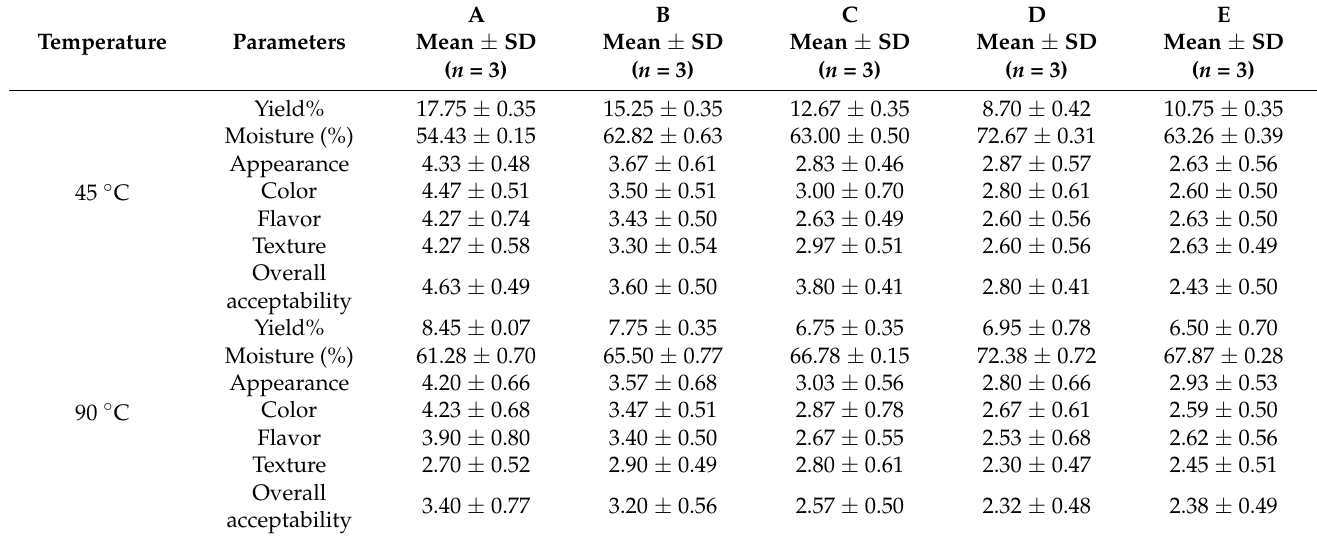
Table 4. The effect of water temperature during lupin milk production and coagulation methods on the yield and sensory analyses of cheeses produced from lupin milk of the PBA Jurien cultivar after storage of cheese at 4 ◦ C for 2 weeks.